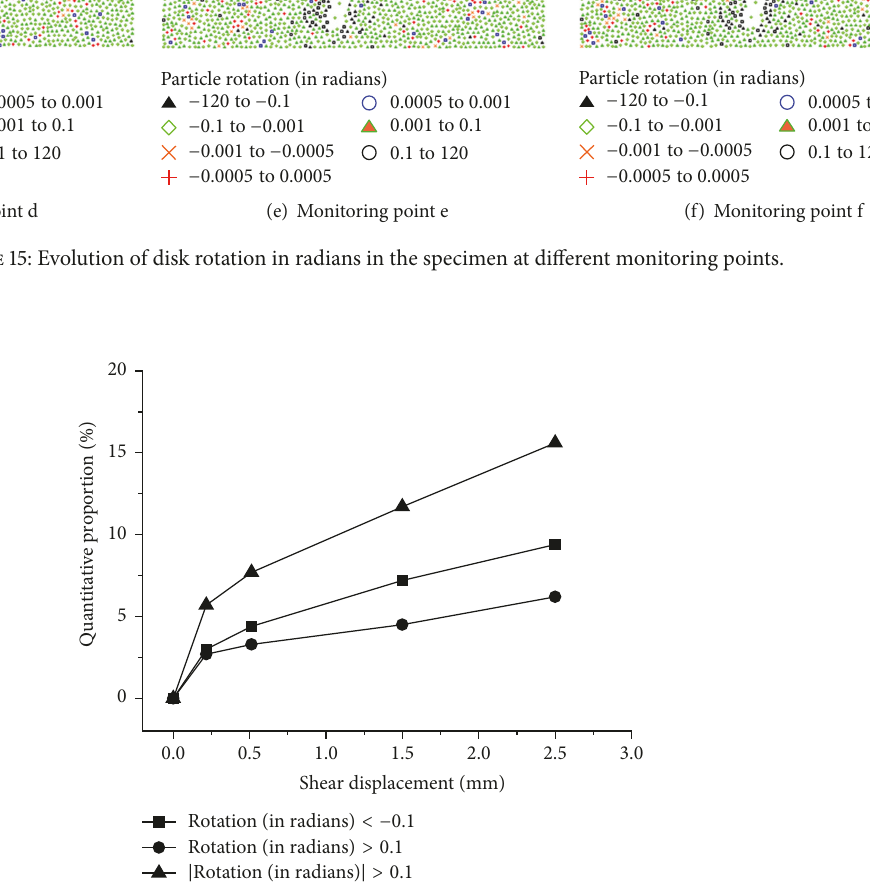
Figure 16: Quantitative proportion variation of rotations exceeding 0.1